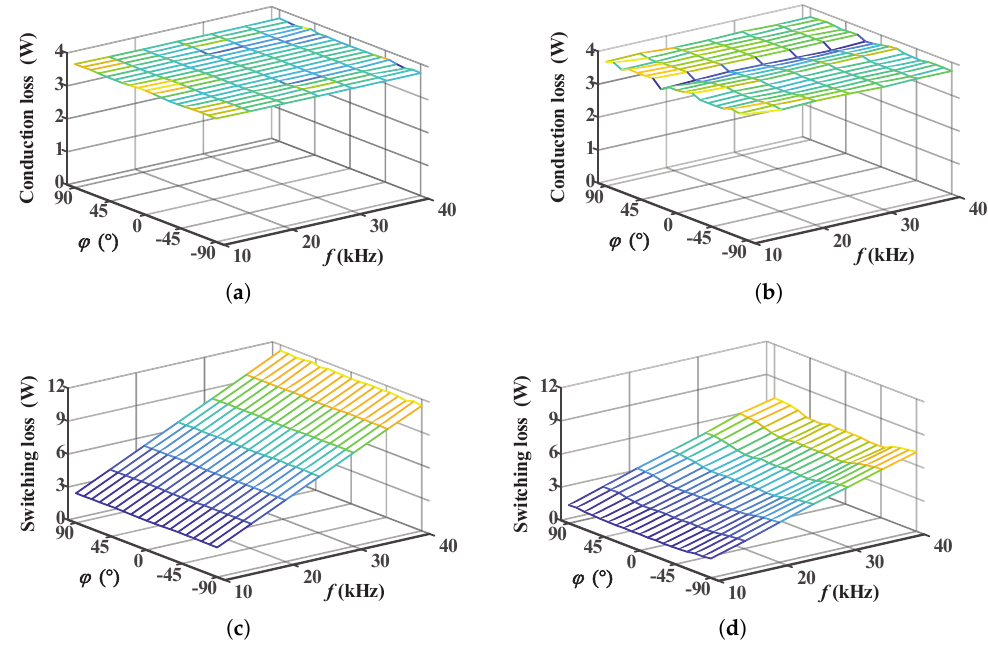
Figure 12. The calculated losses benchmark, ( a ) conduction losses for SVPWM, ( b ) conduction losses for MSL-DPWM, ( c ) switching losses for SVPWM, and ( d ) switching losses for MSL-DPWM.